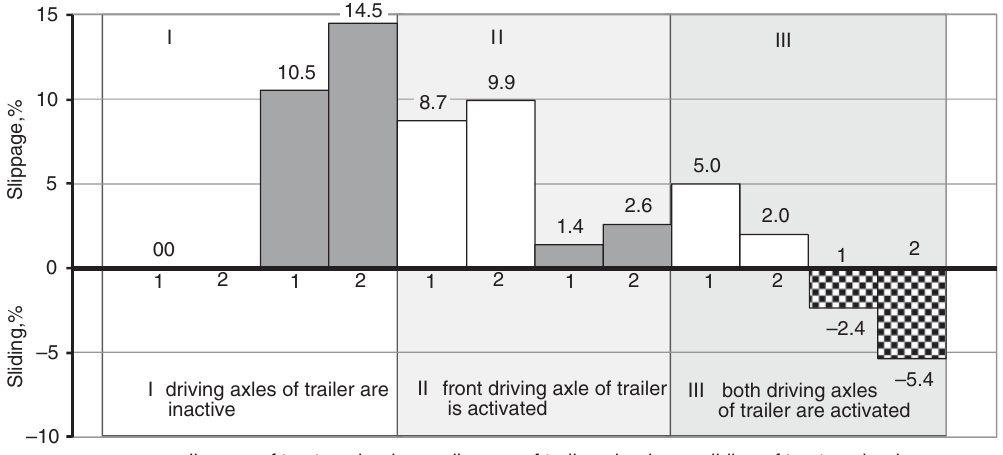
Fig. 9. The dependences of vehicle’s driving wheel’s slippage on the number of activated driving axles and their load, while driving on a plowed field: 1 (cid:2) when total weight of the vehicle is 7100 kg, axle load rates: tractor’s front (cid:2) 0.21, tractor’s rear (cid:2) 0.38, trailer’s front (cid:2) 0.21 and trailer’s rear (cid:2) 0.21; 2 (cid:2) when total weight of the vehicle 11,600 kg; axle load